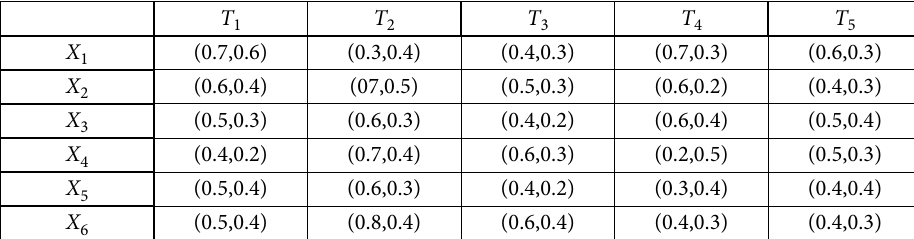
Table 1. Decision matrix with q-ROFNs by the first expert